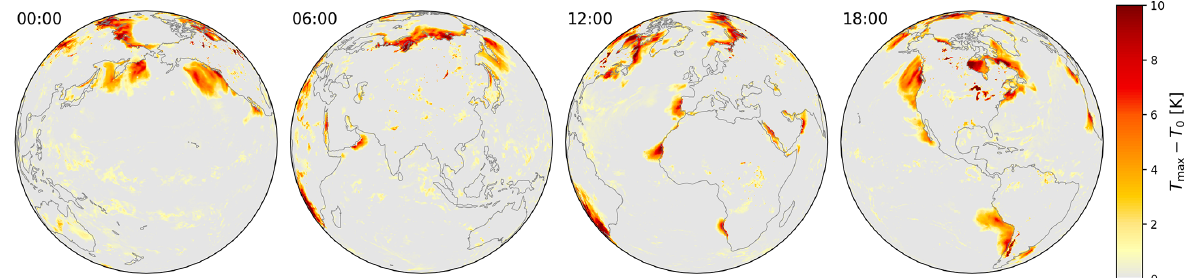
Figure 9. Temperature inversions, expressed as difference between tropospheric maximum and surface temperature, for ERA5 simulations at 00:00, 06:00, 12:00, and 18:00UTC on 18 June 2018.